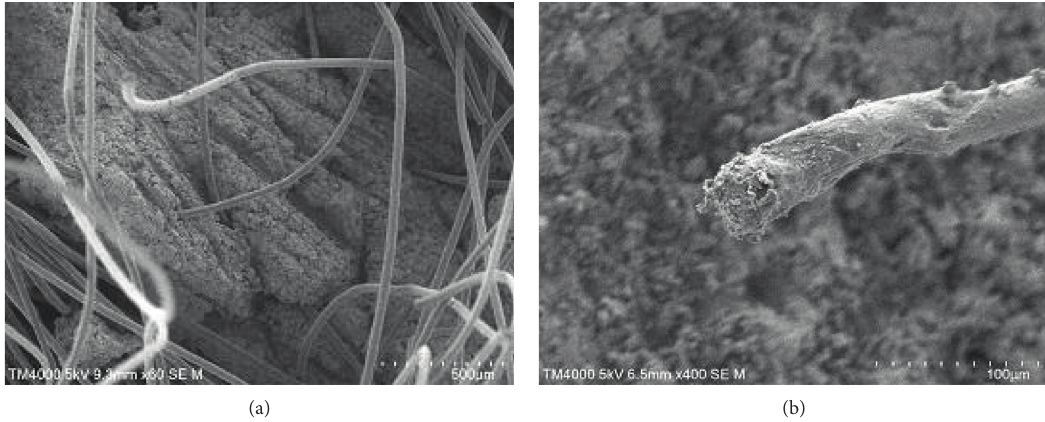
Figure 14: Failure mode of fiber at the reinforcement-soil interface. (a) Pull-out failure. (b) Tensile